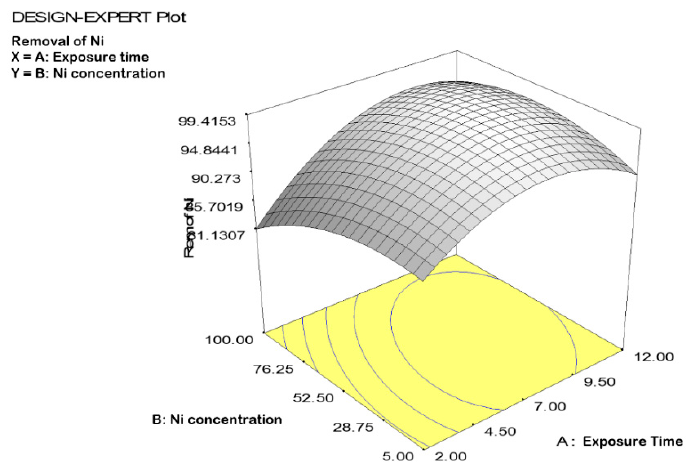
Figure 2. Optimization of Ni removal from water collected in the CW system.